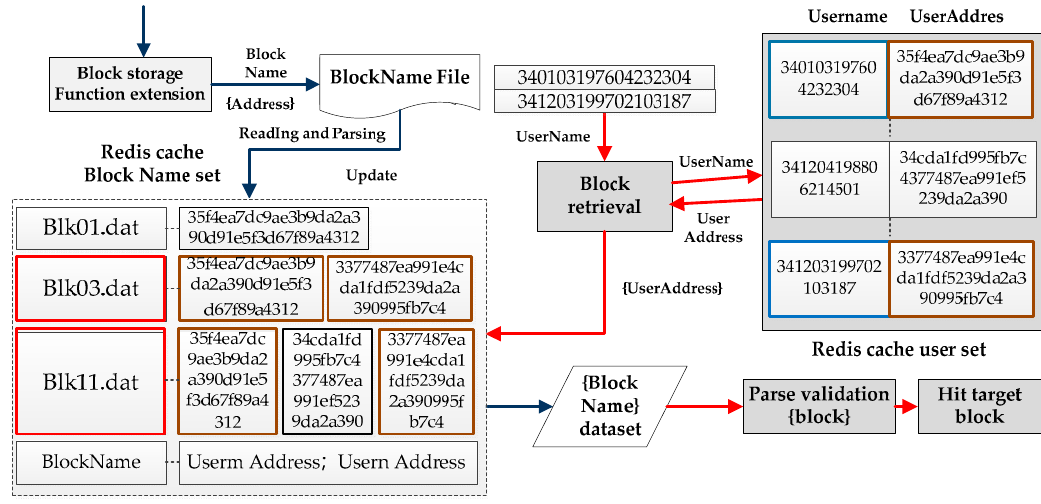
Figure 6. Block file retrieval process.